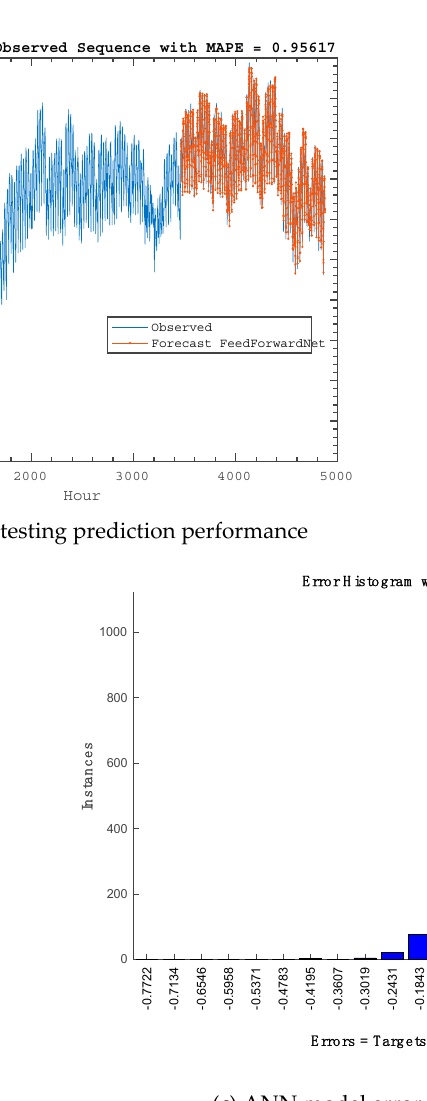
Figure 12. CNN-RNN model prediction performance for Jeddah load: ( a ) training and testing, ( b ) testing, and ( c ) regression plot.